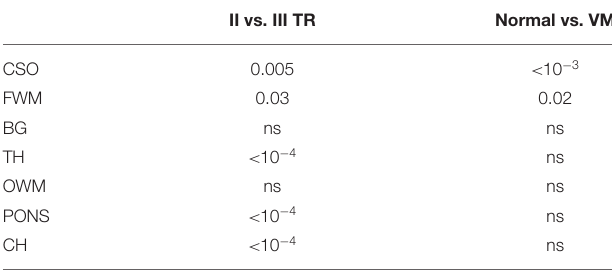
TABLE 1 | Multi-way ANOVA to investigate the effects of brain maturation and VM disease on ADC measurements.